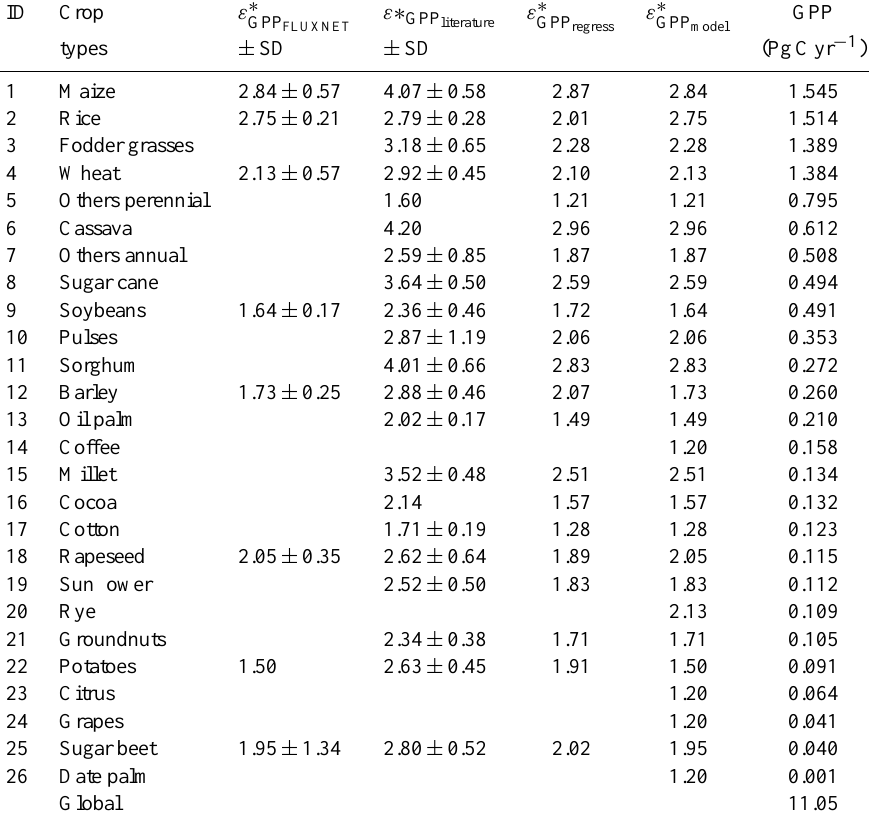
Table 2. ε ∗ used in our study and global cropland GPP estimates for various crop GPP